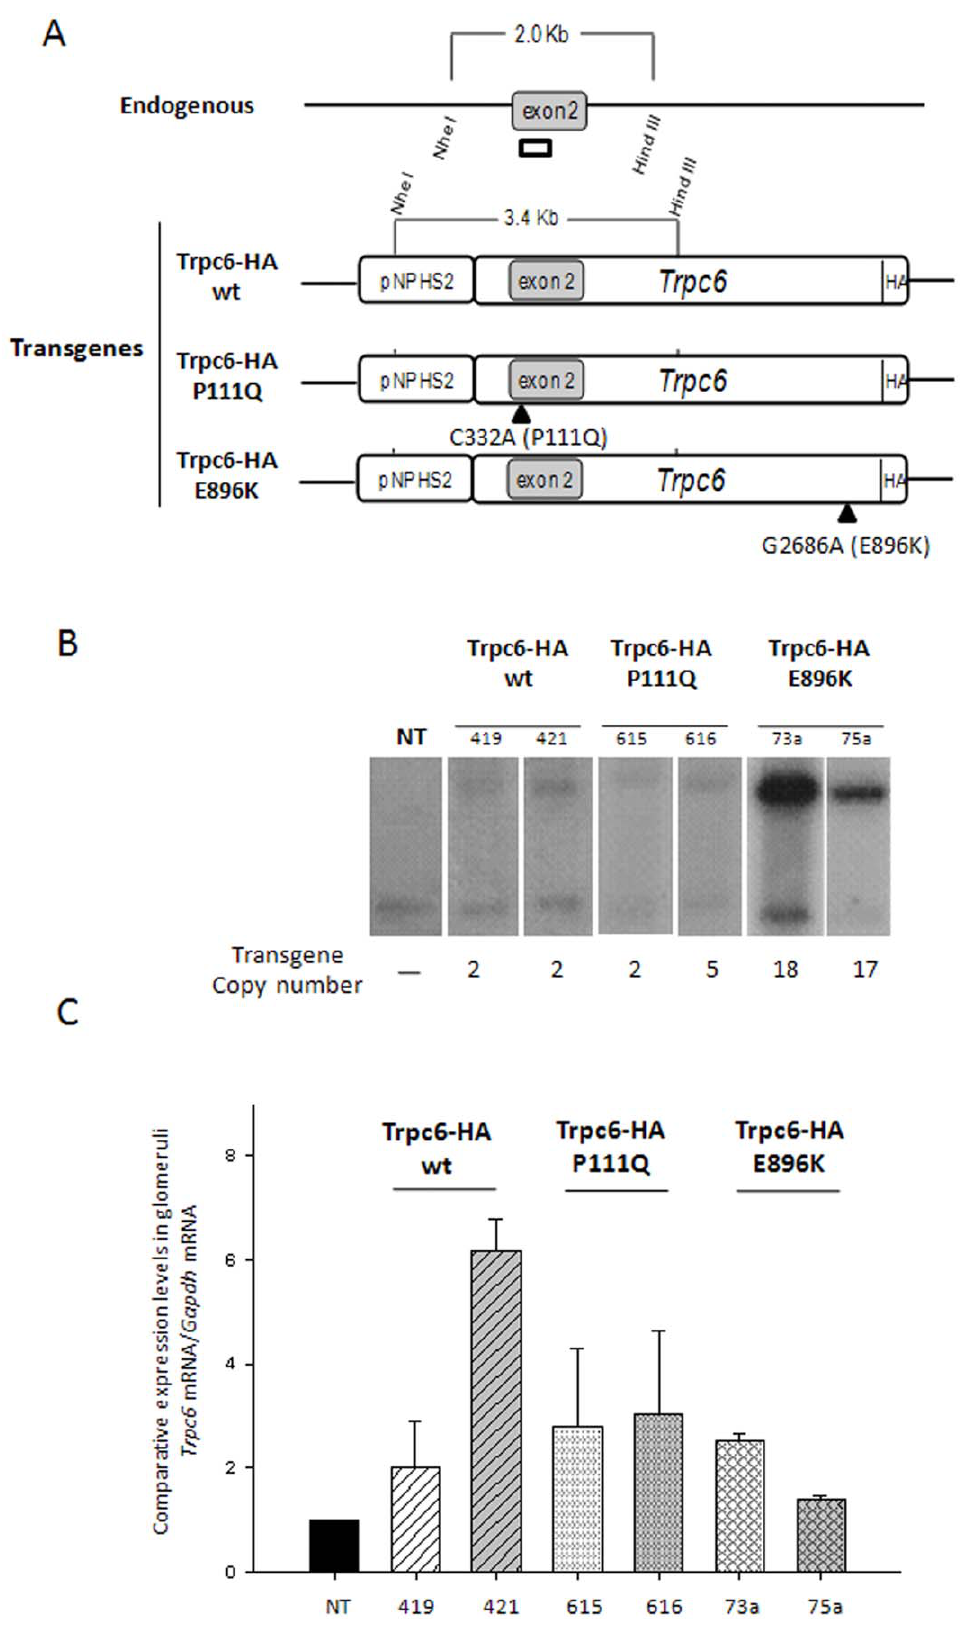
Figure 2. Trpc6-HA transgenes and molecular characterization of transgenic lines. (A) Scheme of the microinjected transgenes Trpc6-HA wt, Trpc6-HA P111Q or Trpc6-HA E896K and the wild type allele for Trpc6 . The complete Trpc6-HA cDNAs were subcloned downstream the pNPHS2